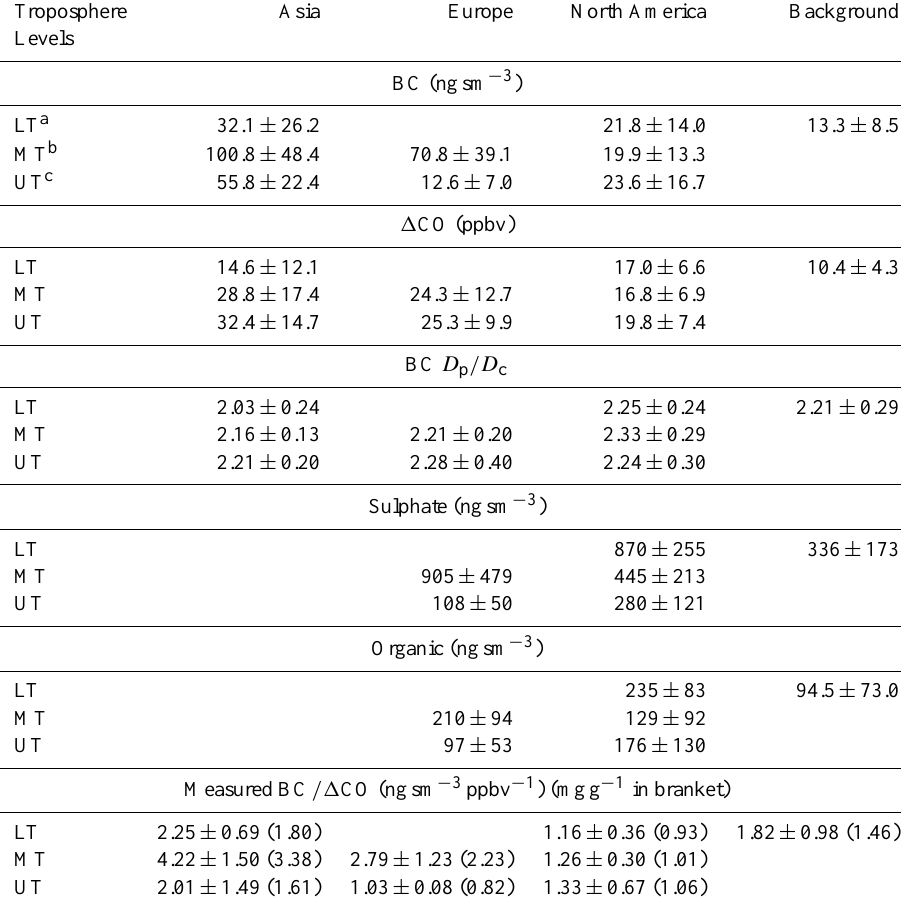
Table 3. Average statistics for BC, (cid:49) CO, BC D p /D c , sulphate, organic mass, and BC /(cid:49) CO in the lower (LT), middle (MT), and upper (UT) troposphere during periods when the different source regions dominated. For BC /(cid:49) CO, both units ngsm − 3 ppbv − 1 and mgg − 1 (in branket) are